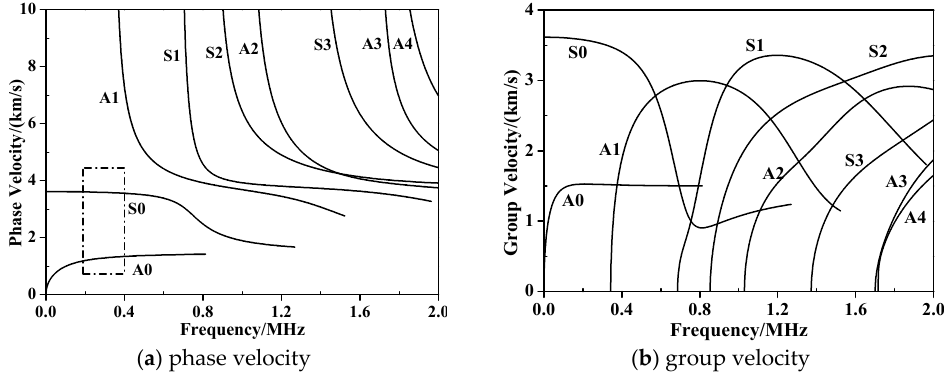
Figure 4. Dispersion property of WGF/epoxy composite laminates with a stacking sequence of [90°/0°] 4 .